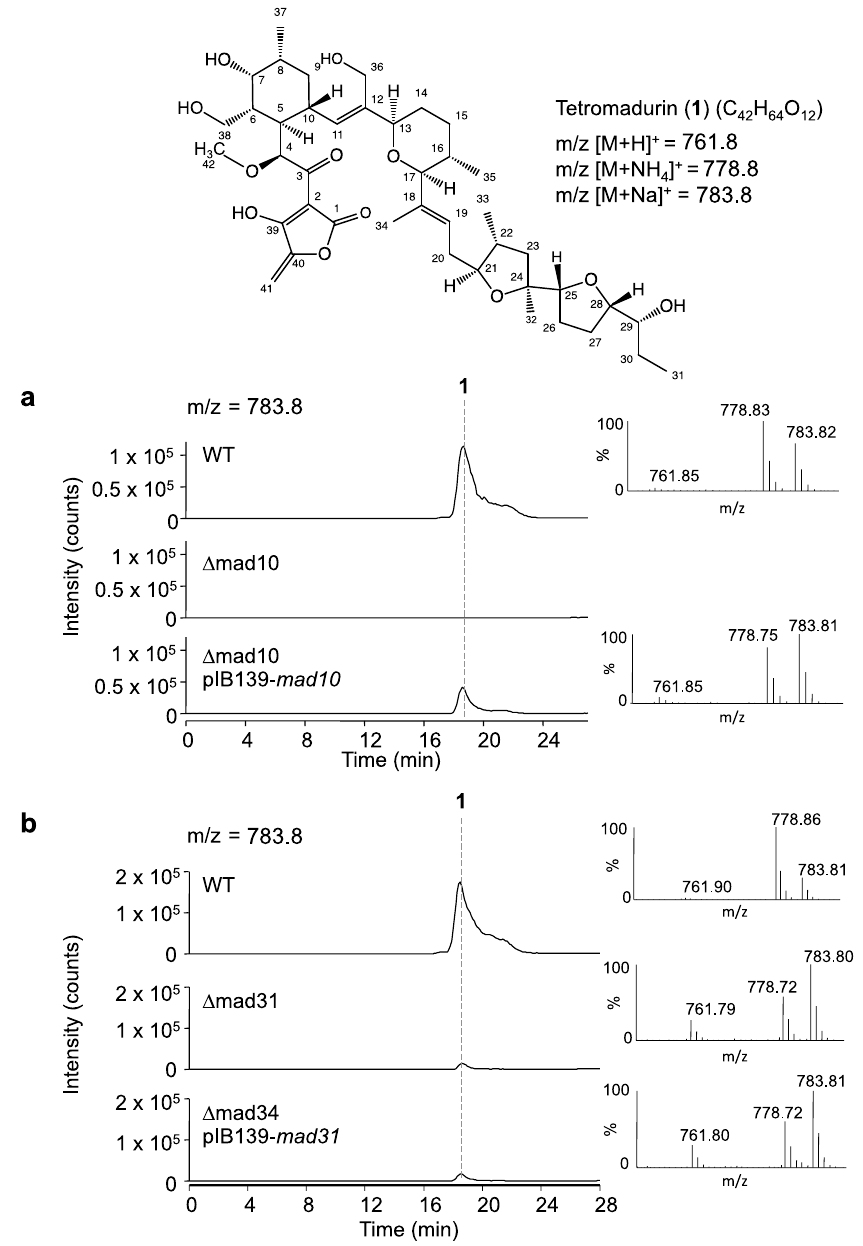
Fig 7. HPLC-MS analysis of A . verrucosospora Δ mad10 and A . verrucosospora Δ mad31. a, The structure and molecular weight of tetromadurin ( 1 ) produced by A . verrucosospora . b, Extracted m/z = 783.8 HPLC-MS spectra from A . verrucosospora wild type (WT), A . verrucosospora Δ mad10, and A . verrucosospora Δ mad10 pIB139- mad10 . c, Extracted m/z = 783.8 HPLC-MS spectra from A . verrucosospora WT, A . verrucosospora Δ mad31, and A . verrucosospora Δ mad31 pIB139- mad31 . All data are representative of three independent experiments. Although A . verrucosospora Δ mad10 no longer produced tetromadurin, analysis of the total ion current (TIC) and photodiode array (PDA) spectrum of this mutant revealed that it pro- duced a new metabolite that we named T-17 ( Fig 8A and 8B ). T-17 was produced by A . verrucosospora Δ mad10 at ca. 50% the level of tetromadurin pro- duction by wild type A . verrucosospora . The mass spectra of T-17 contains peaks for putative